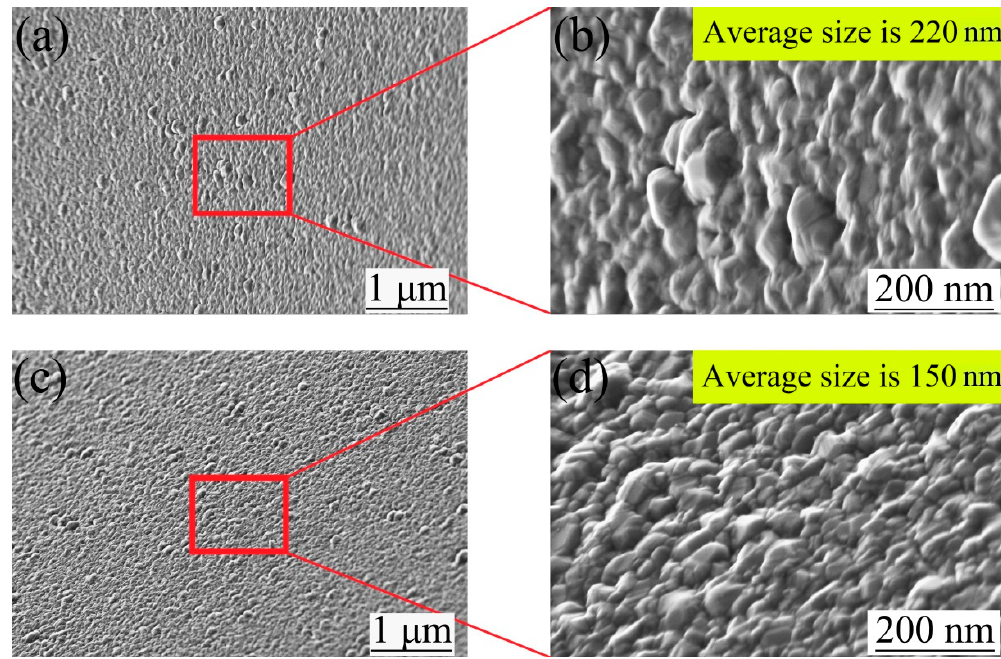
Figure 5. Ag surface micromorphology. ( a , b ) Scheme 1; ( c , d ) scheme 2.